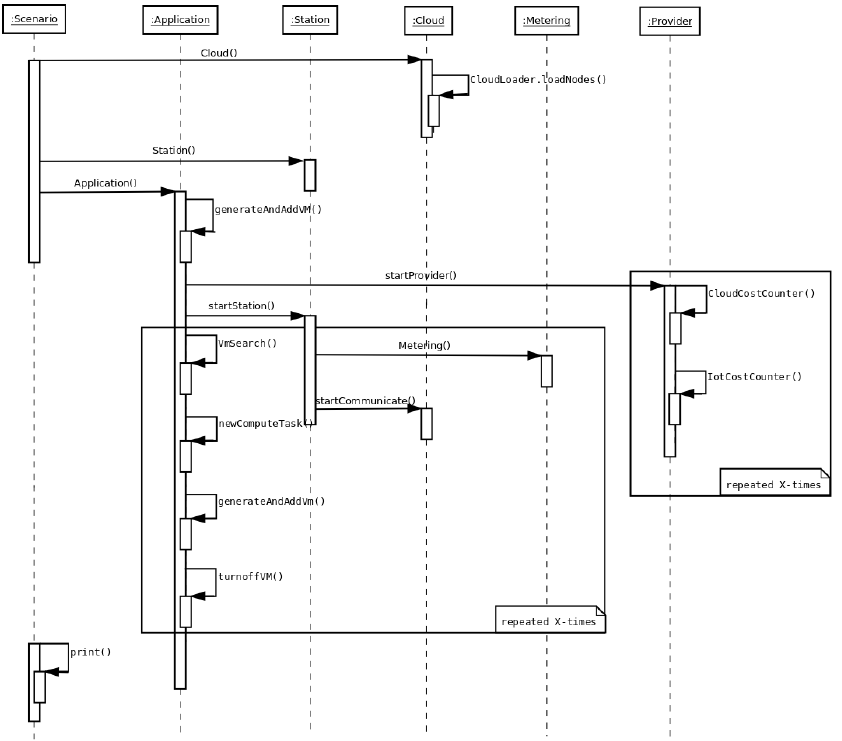
Figure 6. Sequence diagram of the